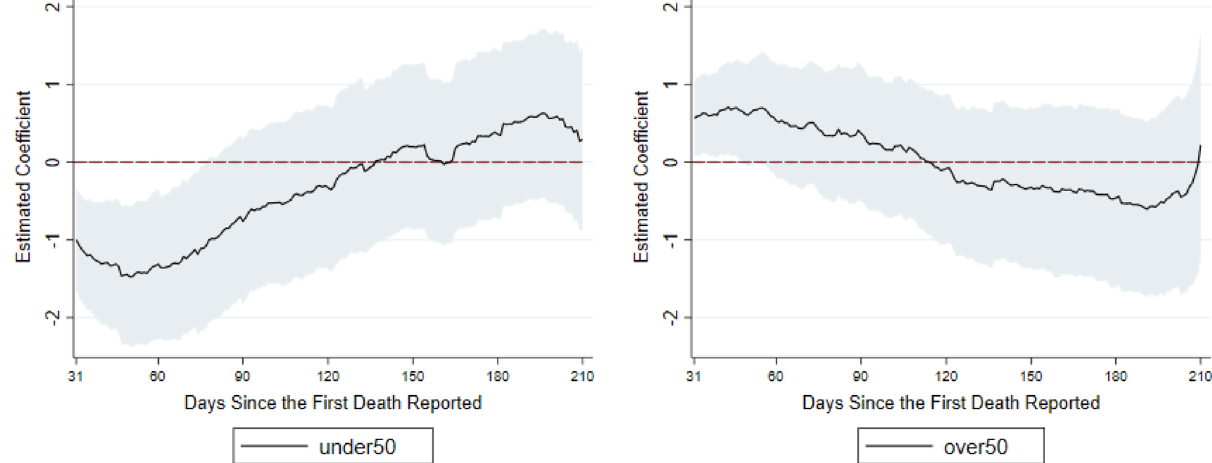
Figure 2. (Model 2) This figure summarizes the estimated effects of under50 and over50 on cumulative deaths in logarithm since the first death reported. The coefficients are estimated effects of BCG vaccination program for day 31 to day 210, compared to the first 30 days. On the left are the estimated under50 effects on weekly log(deaths) which are estimates of α k in Eq. (2). On the right are the estimated over50 effects on weekly log(deaths) which are the estimates of β k in Eq.